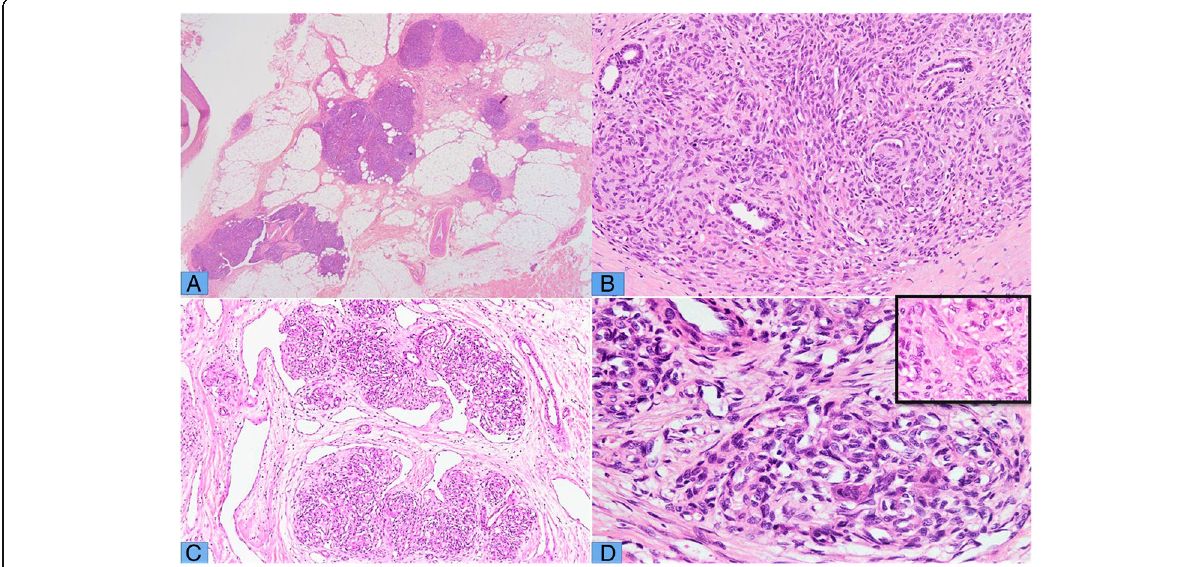
Fig. 2 a H&E stained sections of cutaneous KHE, showing glomeruloid nodules of tumor infiltrating into subcutaneous adipose tissue. b In the dermis, the tumor nodules infiltrate through adnexal structures with entrapment of residual bi-layered eccrine glandular acini. c Tumor nodules with surrounding lymphangioma-like vascular spaces. d Tumor nodules showing few scattered multinucleated giant cells, which is a rare finding in KHE. D Inset) Microthrombi seen within capillary